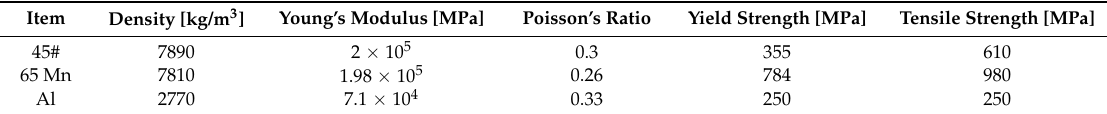
Figure 8. Mesh model of the spiny foot. Table 1. Properties of materials used for the grasping claws module.